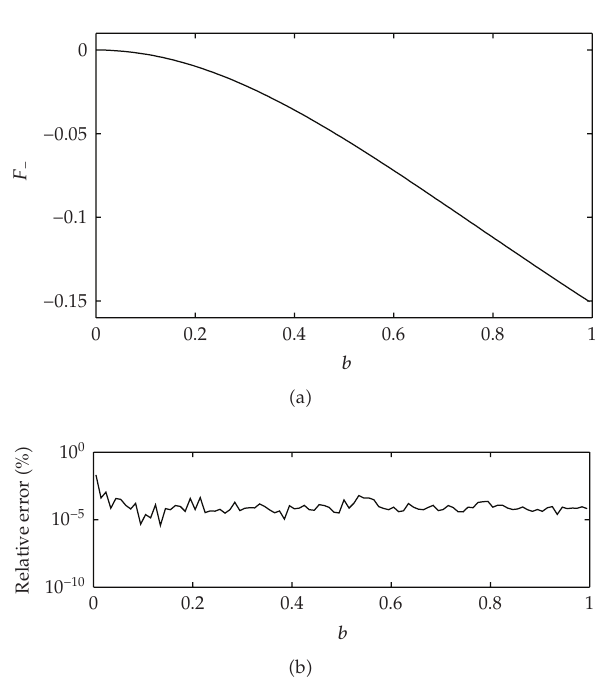
Figure 5: The series F − from (cid:2) 3.12b (cid:3) with the relative error when compared to the integral from (cid:2) 3.16b (cid:3) .